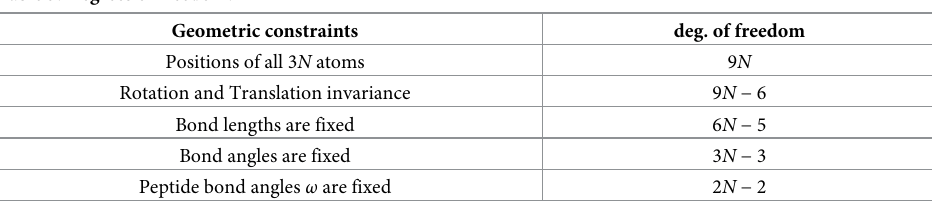
Table 3. Degrees of